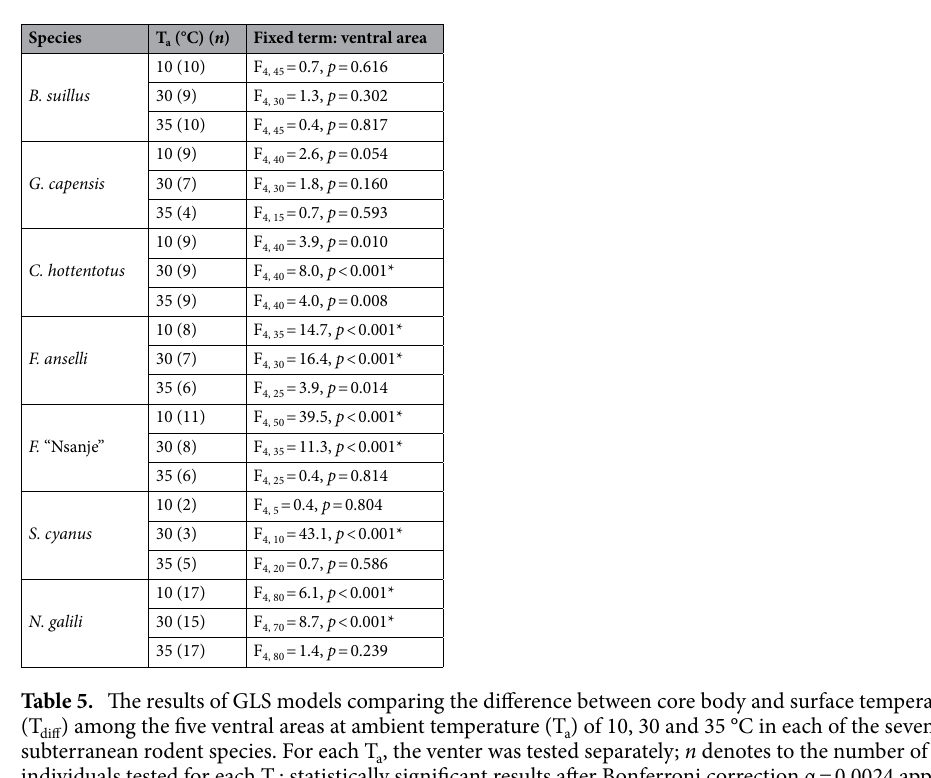
Species T a (°C) ( n ) Fixed term: ventral